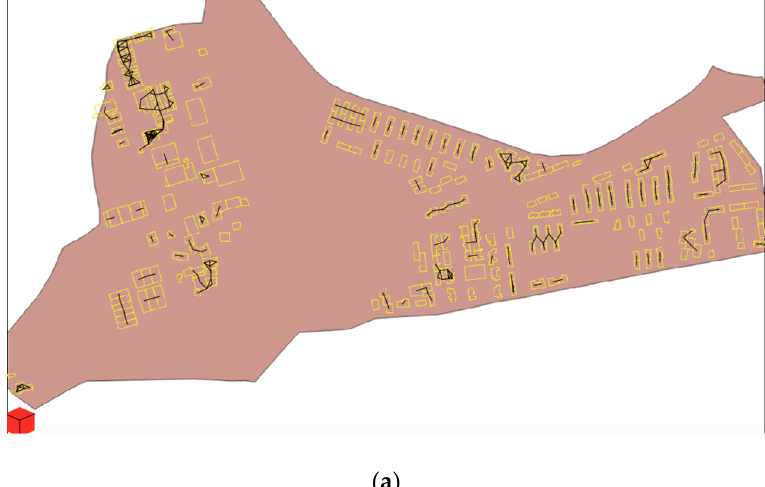
Table 1. Main characteristics of the batteries integrated with the photovoltaics (PV) panels.